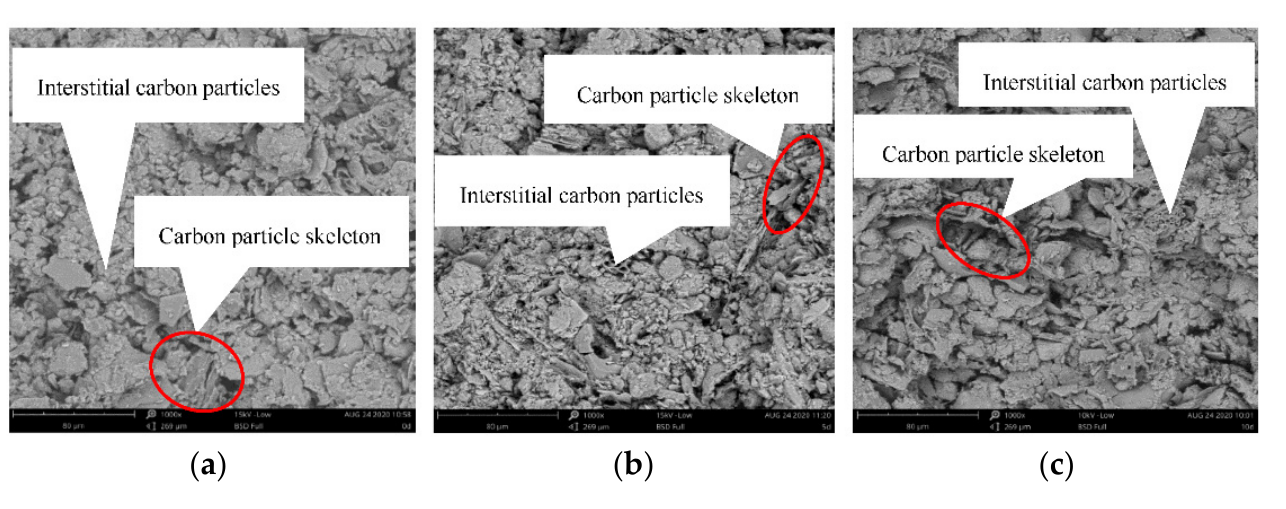
Figure 7. SEM images of biochar–clay mixed soil with bacteria (0 d, 5 d, and 10 d). ( a ) α = 15%, 1000 times magnification, 0 d. ( b ) α = 15%, 1000 times magnification, 5 d. ( c ) α = 15%, 1000 times magnification, 10 d.